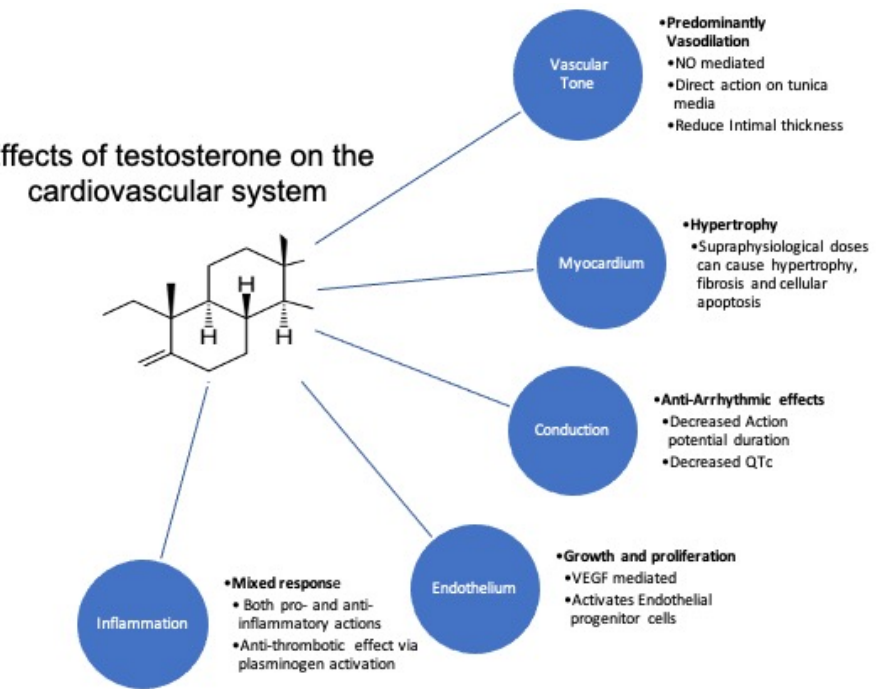
Figure 4. Summary of the effects of testosterone on cardiovascular system. Abbreviations: NO, nitric oxide; VEGF, vasoactive endothelial growth factor; QTc, corrected Q-T interval. Blood androgen levels have been intrinsically related to cardiovascular health.